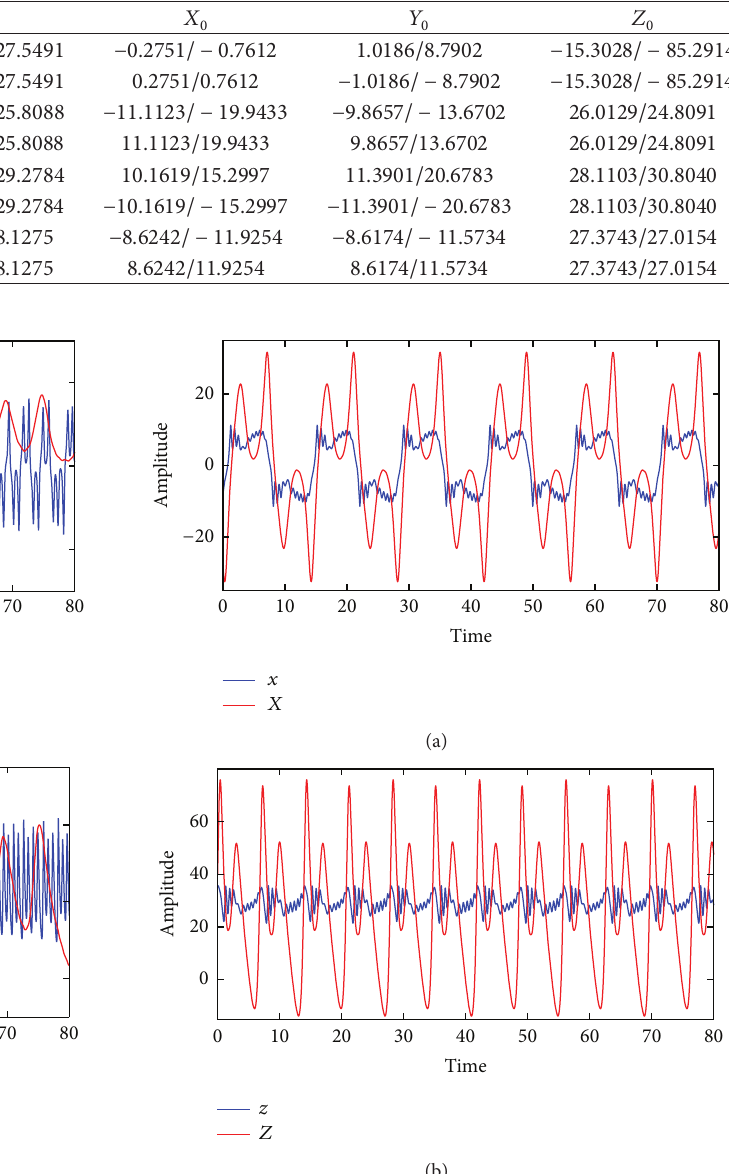
Figure 4: Time evolution of fast and slow dynamic variables for 𝑐 = 0.8